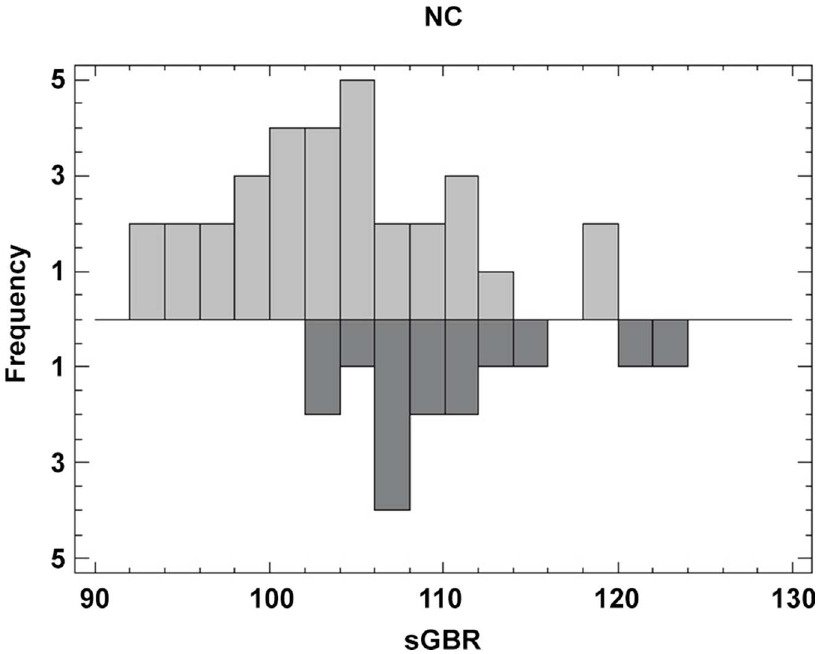
Figure 6. Distribution of the mean CCL (cm) at two nesting areas in the Coral Sea. sGBR (n=15) and NC (n=32).